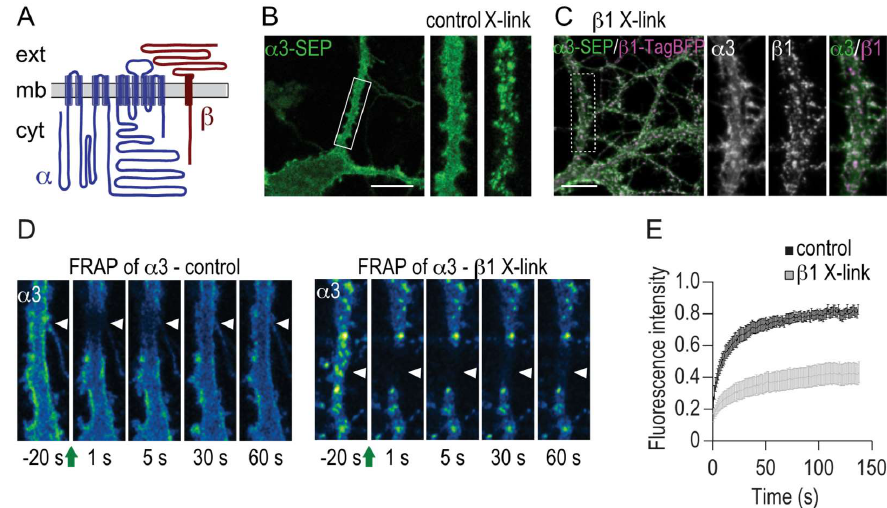
Figure 3. Cross-linking of β1 clusters α3 at the membrane and reduces its membrane dynamics. ( A ) Membrane topology model of the α and β subunit comparing extracellular (ext) and cytoplasmic (cyt) domains. ( B ) Extracellular cross-linking of α3-SEP using goat polyclonal anti-GFP (5 μg/mL, 10 min) and polyclonal donkey anti-goat IgG (10 μg/mL, 10 min) leads to reorganization and clustering of α3 in the membrane. Representative image of a hippocampal neuron at DIV24 expressing α3-SEP. The region in the white rectangle is shown in higher magnification as inset before (control) and after (X-link) cross-linking. Scale bar represents 10 μm. ( C ) Cross linking of β1 clusters α3. Representative image of a hippocampal neuron at DIV24 expressing α3-SEP and β1-TagBFP and subjected to antibody cross-linking against β1-TagBFP with rabbit polyclonal anti-TagRFP (5 μg/mL, 10 min) and polyclonal goat anti-rabbit IgG (10 μg/mL, 10 min). Scale bars represent 5 μm. Single fluorescence channels from the region in the white rectangle are shown in higher magnification as insets. ( D , E ) Fluorescence recovery after photobleaching (FRAP) analysis of α3 dynamics in dendritic segments in control conditions ( D , left) or in dendritic segments subjected to antibody cross linking of β1 ( D , right). Time lapse images following photobleaching of α3-SEP were pseudo-color-coded for SEP intensity. The green arrows indicate photobleaching, and white arrowheads indicate the regions that have undergone photobleaching. ( E ) Mean ± SEM of the normalized fluorescence intensity over time in dendritic segments in control conditions (black, n = 10 cells, 3 cultures) and when β1 is cross-linked (grey line, n = 11 cells, 3 cultures).